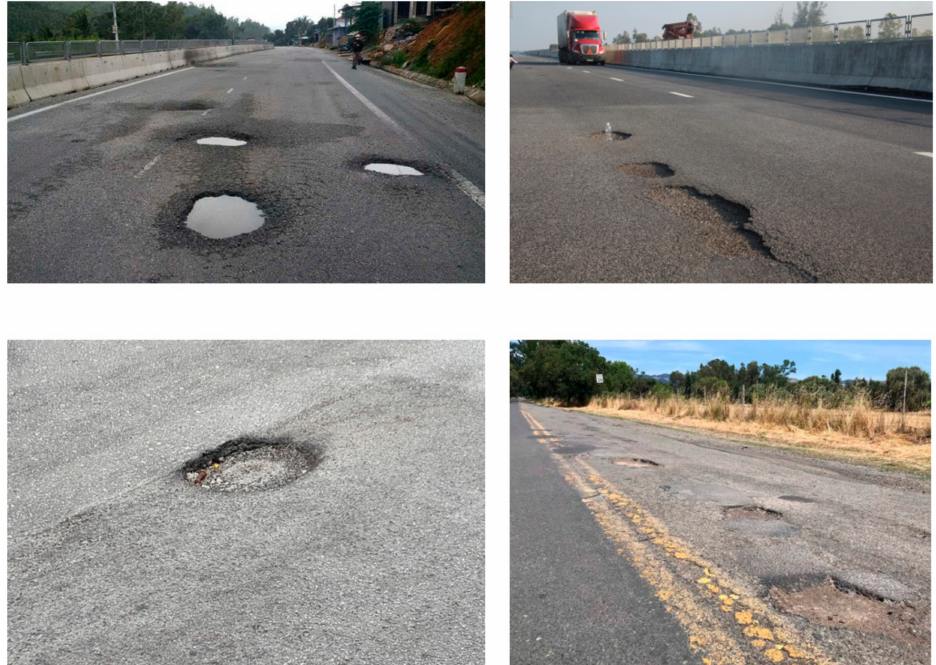
Figure 4. Typical pothole images on road surfaces of the testing